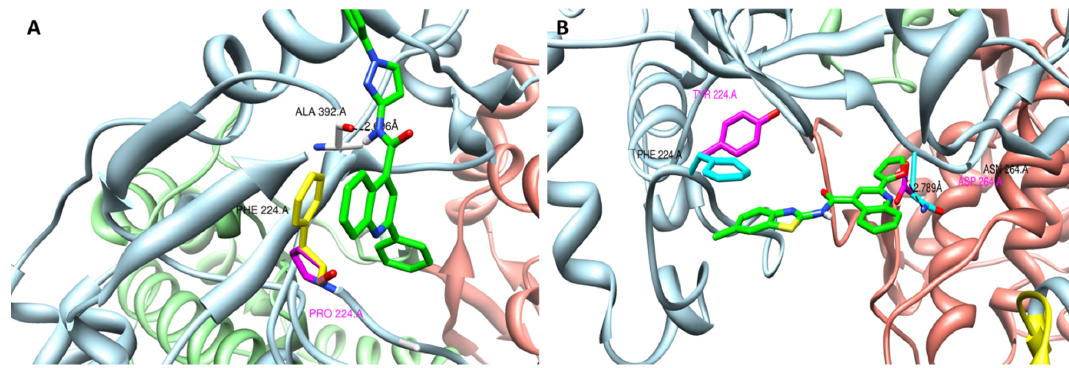
Figure 6. Modelling of ( A ) TO502-2403 (CSFCII) near the position F224P in the RNA-dependent RNA polymerase and ( B ) TO505-6180 (CSFCI) near the position F224Y and N264D in the RNA-dependent RNA polymerase.The different domains of the BVDV polymerase are colored as follows—the N-terminal domain is in yellow (residues 92 to 138), the finger domain is in blue (residues 139 to 313 and residues 351 to 410), the palm domain is in green (residues 314 to 350 and residues 411 to 500), and the thumb domain is in red (thumb, residues 501 to 679). The ligand carbon atoms are coloured green. The hydrogen bond is indicated with the dotted line.